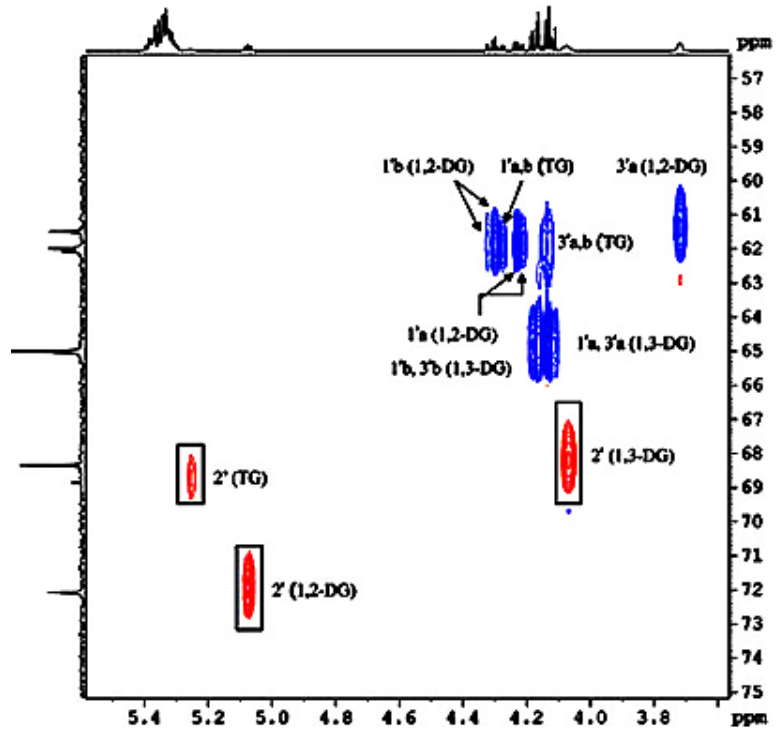
Figure 19. 600 MHz HSQC-DEPT NMR spectrum of DAG olive oil in CDCl 3 solution, showing one bond correlations between the glycerol backbone protons and carbons; negative (blue color) signals for the CH 2 carbons and positive (red color) signals for the CH carbons. Adopted, with permission, from [59]. Copyright 2011, Springer AOCS.